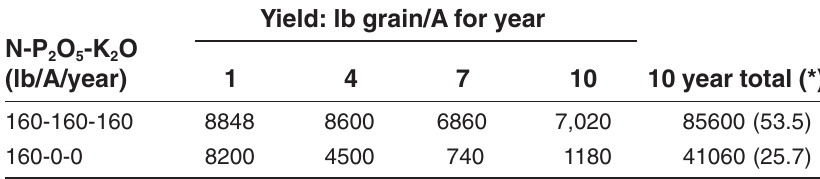
10-year Results of NPK vs. N Fertilization of Dryland Corn[4]